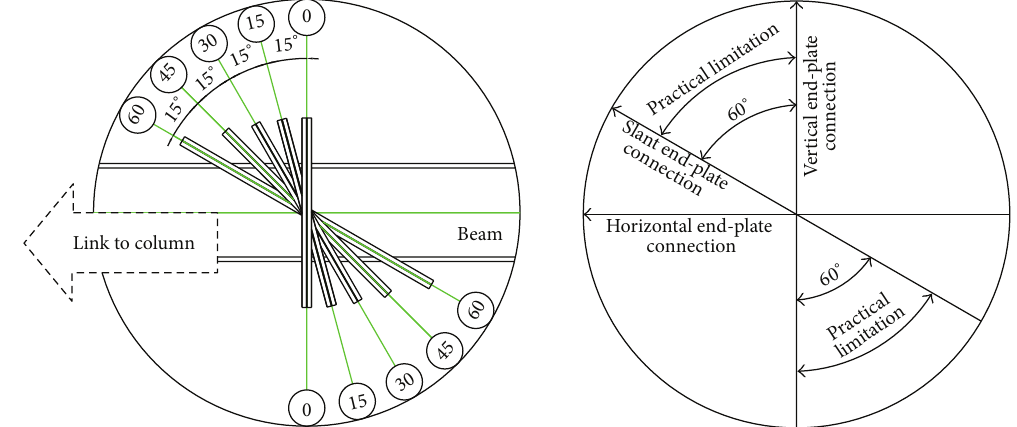
Figure 2: Practical angles in slant end-plate connection.